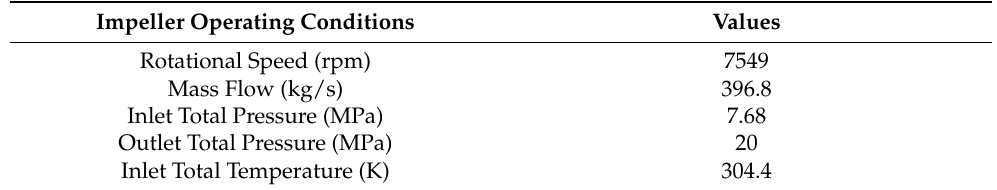
Table 3. Centrifugal compressor’s design parameters.